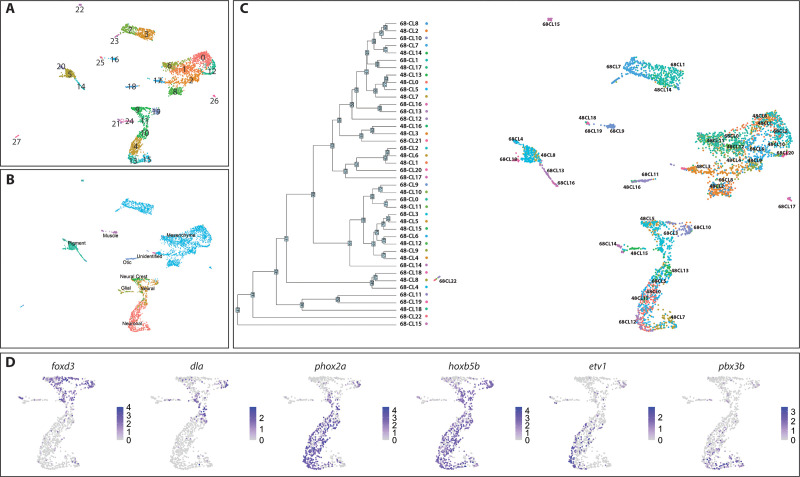
Annotated sox10:GFP+ atlas labeled by cell types.(A) UMAP labeling the 27 new clusters formed after merging the 48–50 and 68–70 hpf sox10:GFP+ datasets. (B) Following label transfer integration, major cell type classifications (Figure 1) group together into distinct clusters across the UMAP. (C) High-resolution visualization of both clustering of original cluster labels, as well as their position within the UMAP. Cell categories segregate in the dendrogram largely as expected from the UMAP visualization. (D) Additional markers, including foxd3, dla, phox2a, hoxb5b, etv1, and pbx3b, are shown by UMAP for validation of the neural/neuronal clusters.